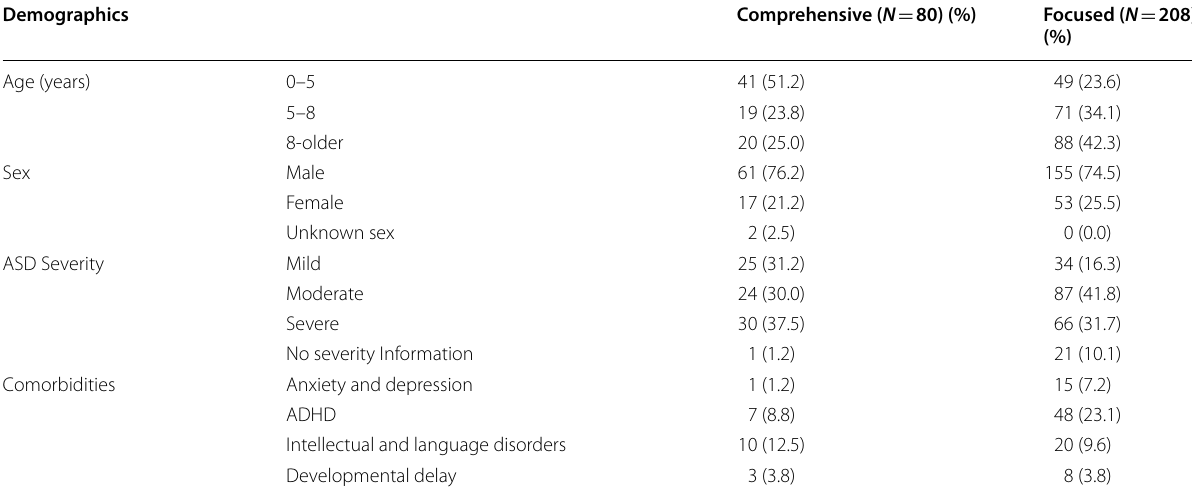
Table 2 Demographics table showing the breakdown of the patients in the training dataset based on the age, sex and (ASD severity). The table also shows the distribution of various comorbidities between the two types of ABA treatment